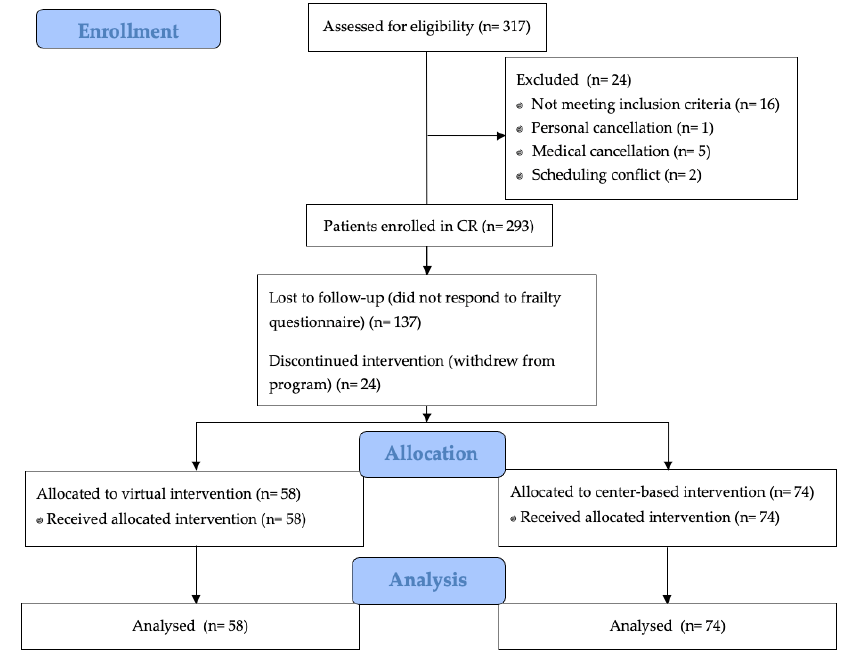
Figure 1. Flow diagram of study enrollment and CR program allocation. Table 1. Demographic information of center-based and virtual cardiac rehabilitation participants at CR admission.